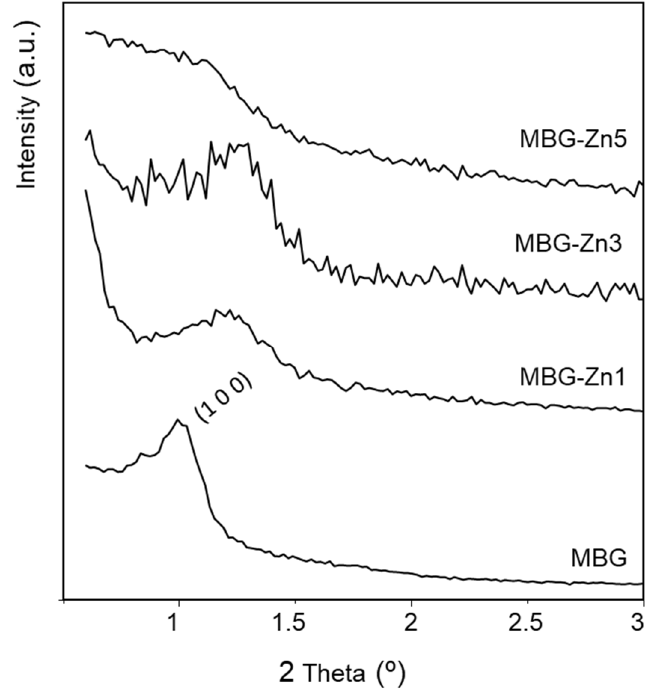
Figure 1. Low angle XRD patterns for MBG and Zn-containing MBGs.